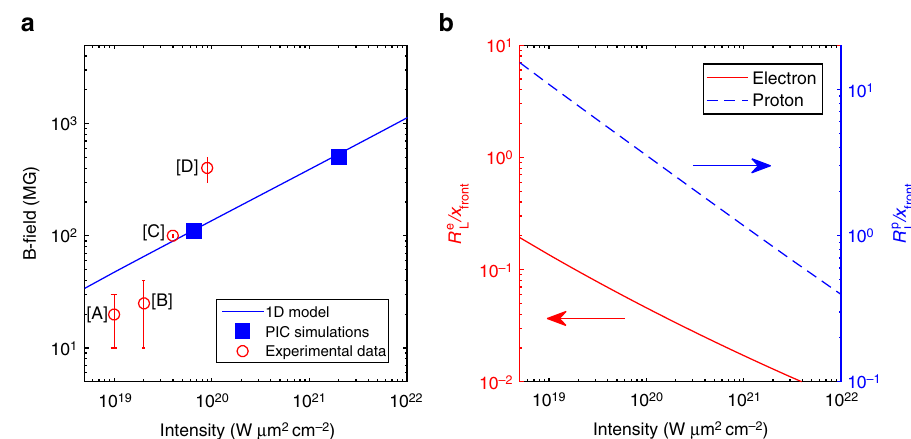
Fig. 2 Magnetic- fi eld strength and particle magnetization vs. laser intensity. a Blue solid curve: magnetic fi eld strength (in MG) as a function of laser intensity ( I L λ 2 ) from the 1D model (see text for details on the parameters) taken at 350 fs after the plasma expansion starts (i.e., corresponding to the L temporal peak for the 700 fs pulse). Experimental data are shown as red points ([A] correspond to ref. 27 , [B] to ref. 29 , [C] to ref. 28 , and [D] to ref. 30 ), while PIC simulation results are shown as blue boxes (see Fig. 1). b Normalized Larmor radii of electrons ( R e blue), at the laser intensity peak, as predicted by the 1D model. The laser parameters are those of Fig. 1e – h: ϕ L = 1.6 μ m, τ L = 700 fs and λ L = 1 μ